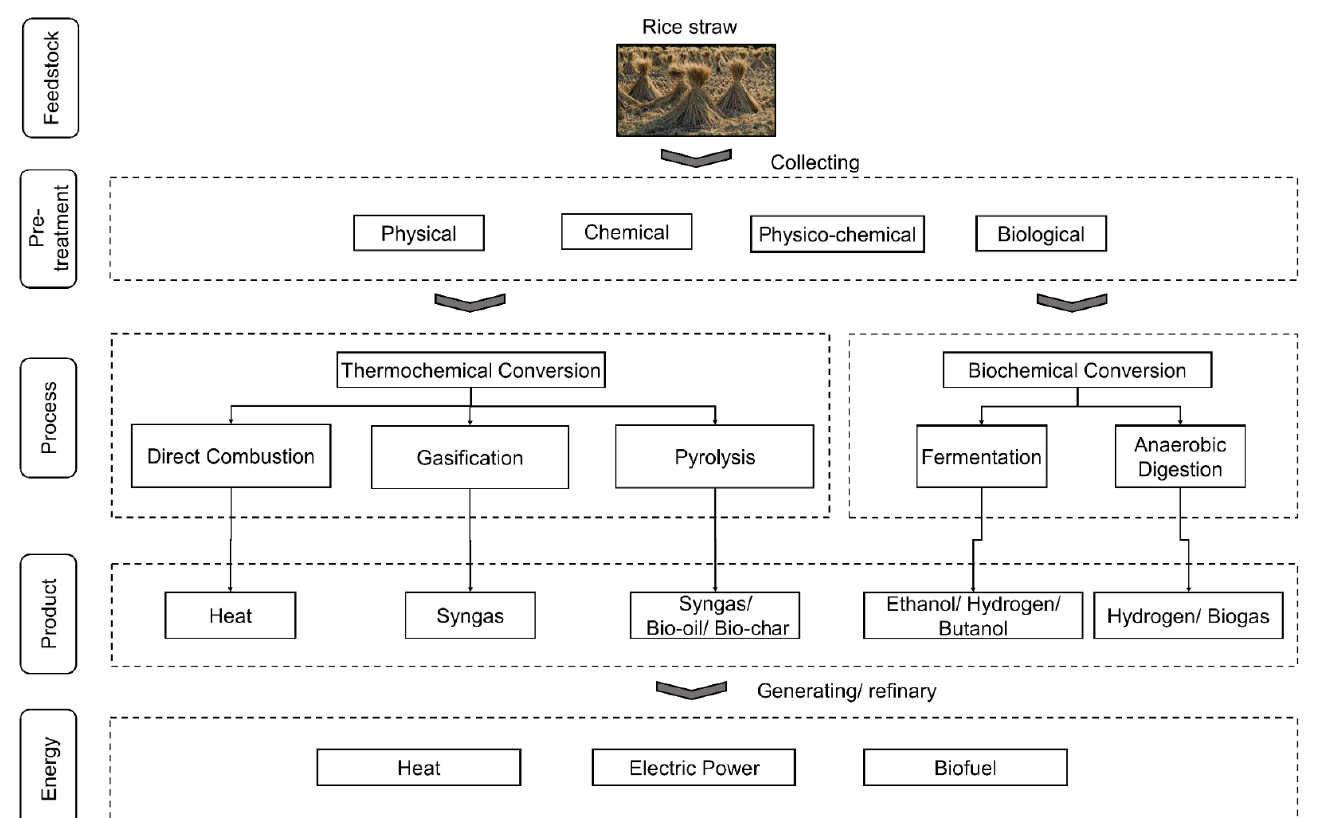
Figure 3. Technologies for conversion of rice straw to bioenergy.